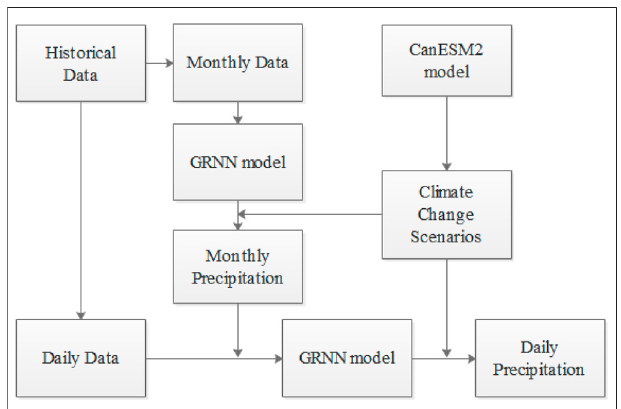
FIGURE 2 | The improved precipitation prediction model based on the generalized regression neural network (GRNN)